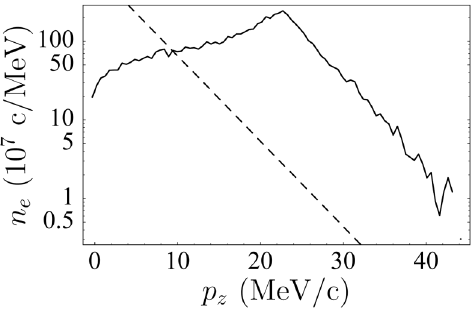
FIG. 12. Electron bunch energy density for the same initial parameters as Fig. 11, that is, total beam charge Q (cid:1) 5 nC , T (cid:1) 4 MeV , radius a (cid:1) 6 (cid:4) m , half-length a temperature k B (cid:1) 2 mrad , average distance between 10 (cid:4) m , divergence x 0 max (cid:1) 422 nm , and cutoff radius r macroparticles n (cid:6) 1 = 3 0 Part (a) shows the input electron distribution and (b) after a vacuum propagation of s (cid:1) 1 : 5 mm